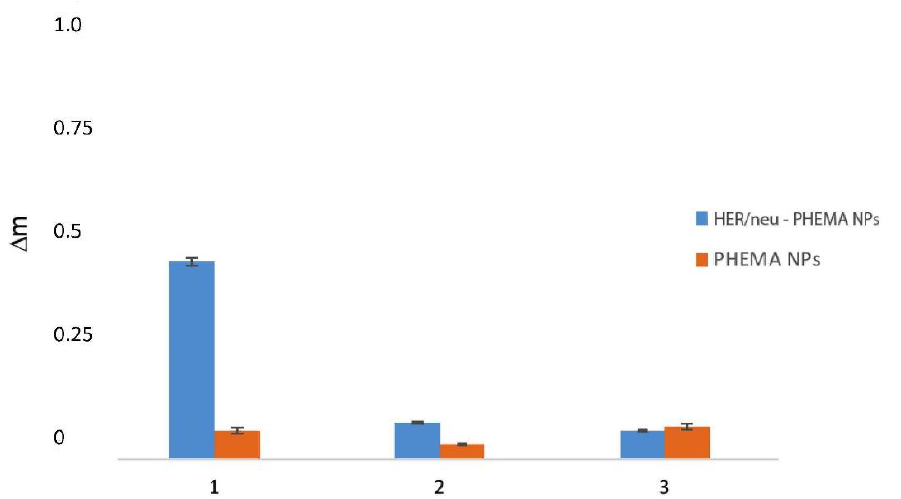
Figure 5. ∆ m values of HER2/neu antibody based poly hydroxymetacrylate nanoparticles (PHEMA Figure 5. Δm values of HER 2/neu antibody based poly hydroxymetacrylate nanoparticles NPs) coated (blue) and only PHEMA NPs coated (orange) QCM chip (1: SKBR3, 2: MDA-MB 231, 3: (PHEMA NPs) coated (blue) and only PHEMA NPs coated (orange) QCM chip (1: SKBR3, 2: Fibroblast MDA-MB 231, 3: Fibroblast cells).